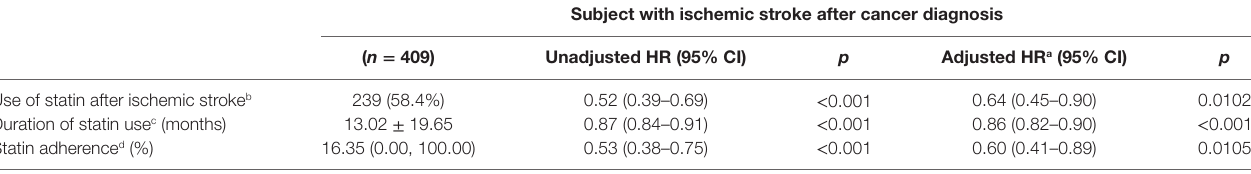
TaBle 4 | Risk of mortality after ischemic stroke in patients with cancer according to use of statin: population data from the Korean National Health Information Service- National Sample Cohort. subject with ischemic stroke after cancer